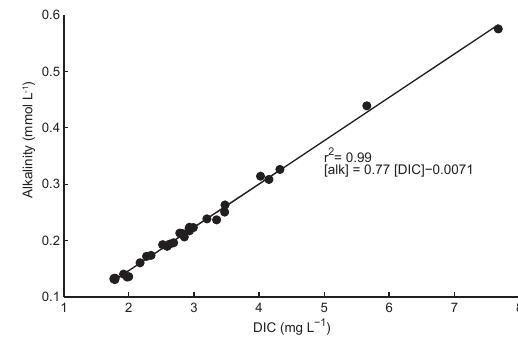
Fig. A2. Daily concentrations of alkalinity and DIC for Abiskojokken outlet for entire April